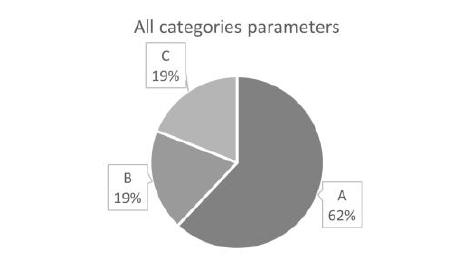
Figure 5 . Percentage of parameters automatically calculable (A), manually calculable (B) and not calculable with CIM as it exists